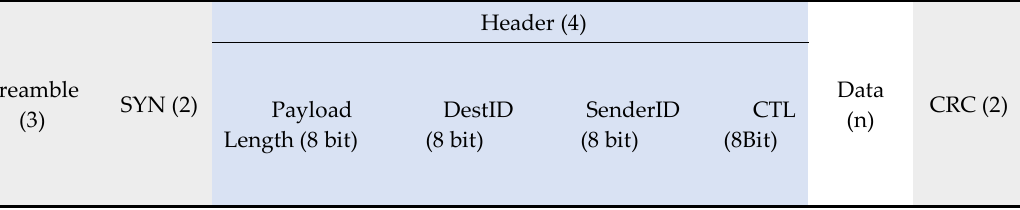
Figure 6. Implemented packet structure.